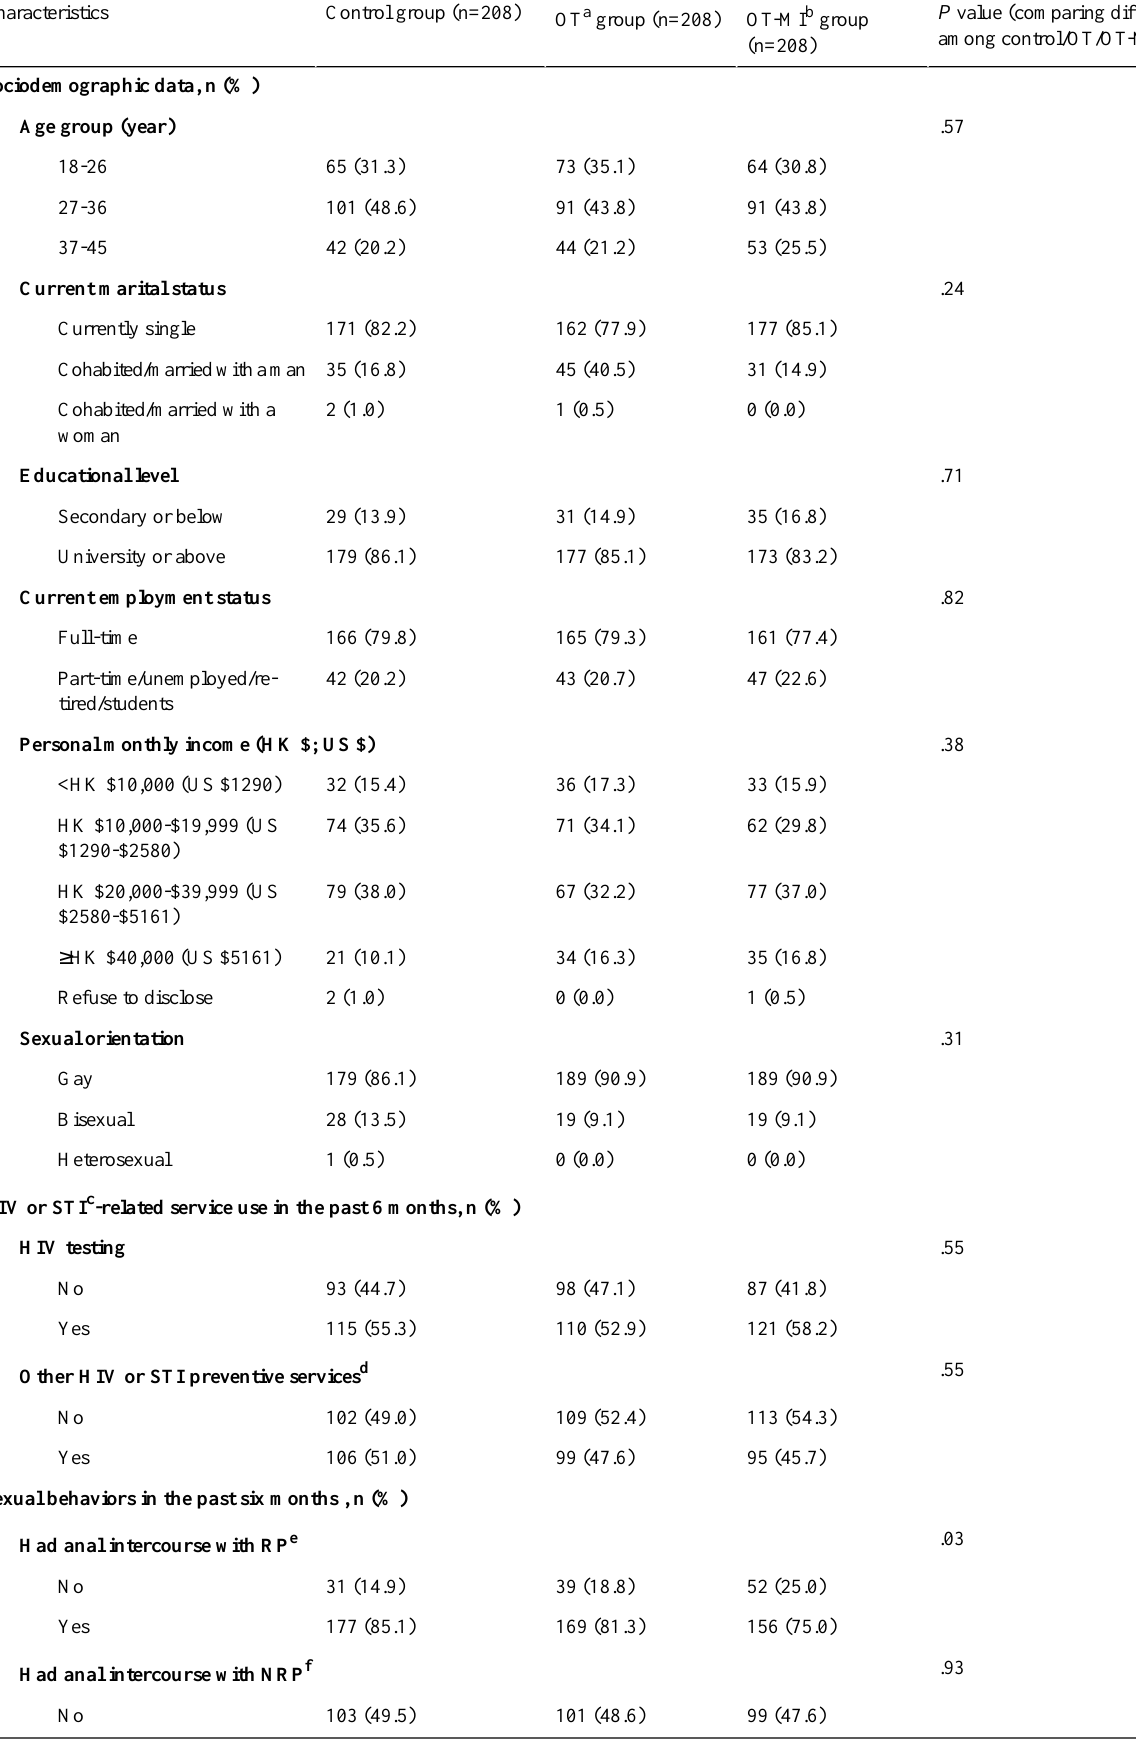
P value (comparing